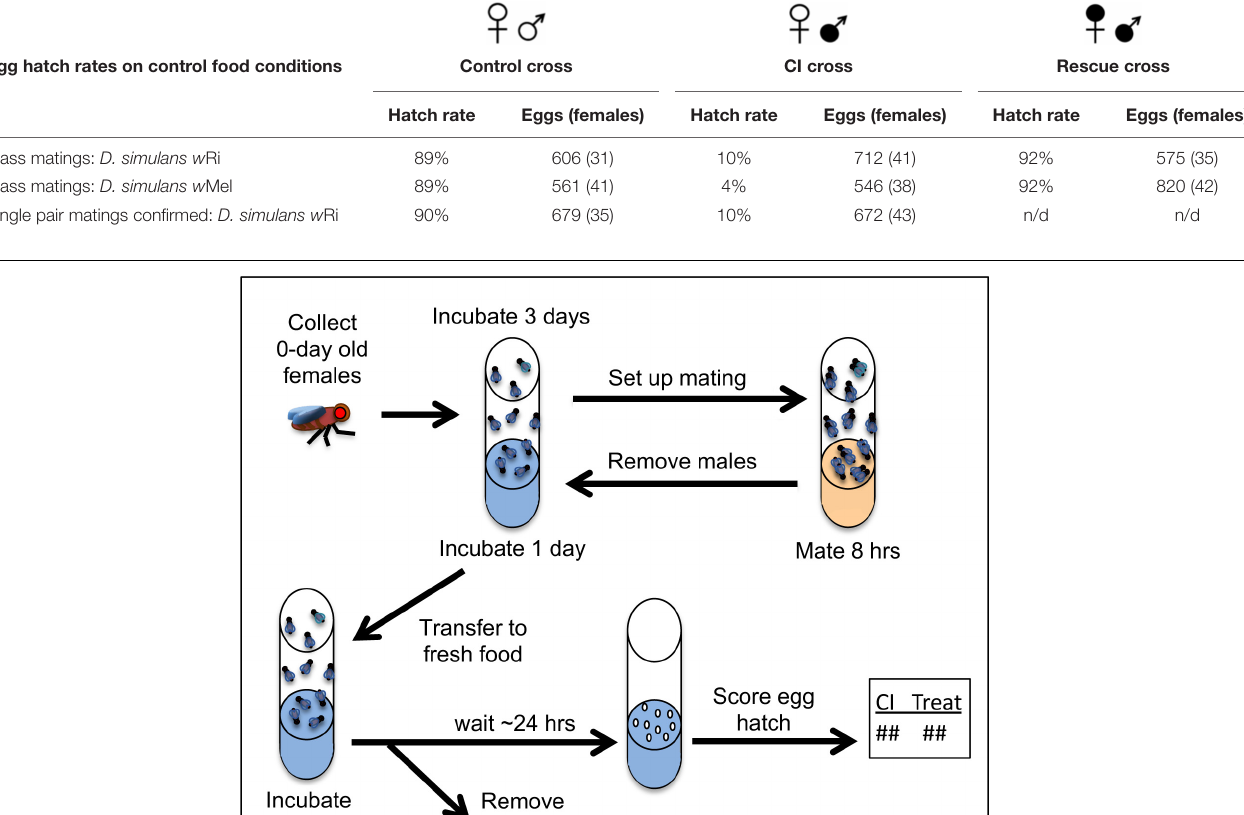
TABLE 1 | Egg hatch rates from CI-related crosses on control food.